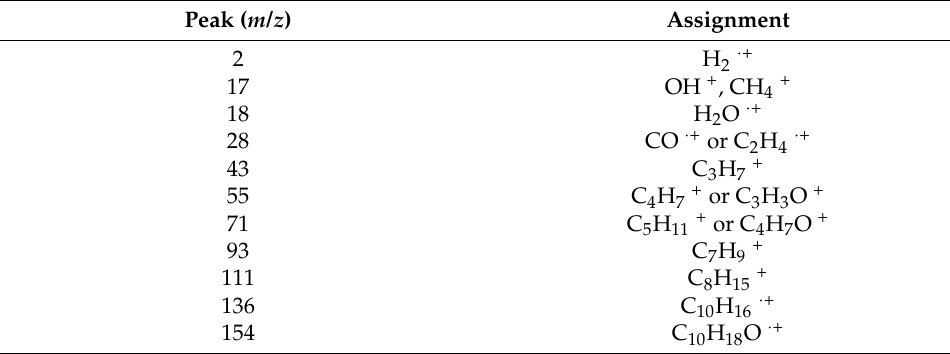
Table 2. Peak assignment in terpinen-4-ol RGA mass spectra. Peak ( m/z )